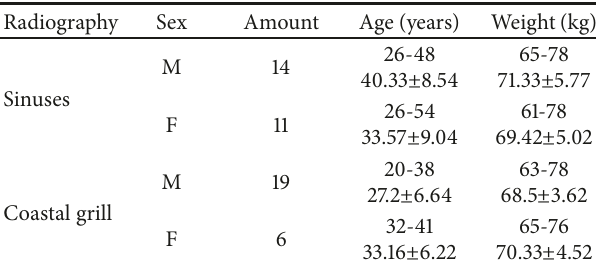
Table 1: Sociodemographic characteristics.